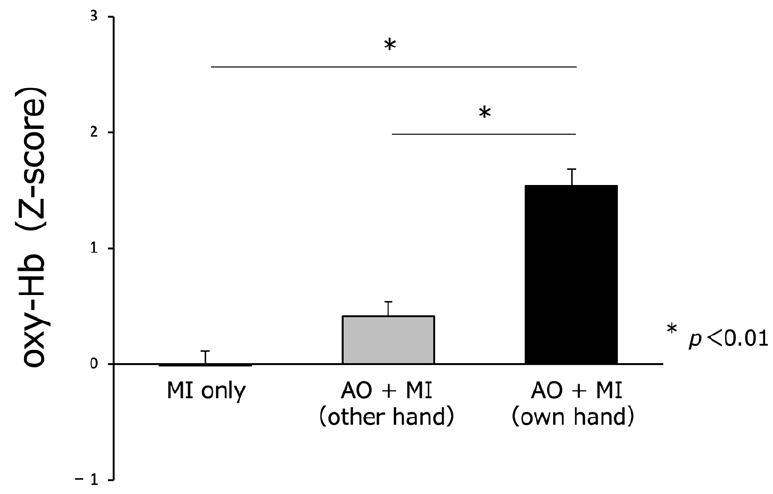
Figure 6. Comparison of oxygenated hemoglobin (oxy-Hb) (Z-score) during the MI of paralyzed upper limbs. Oxy-Hb in the cortical region was significantly higher in own hand AO + MI than in MI only or other hand AO + MI.